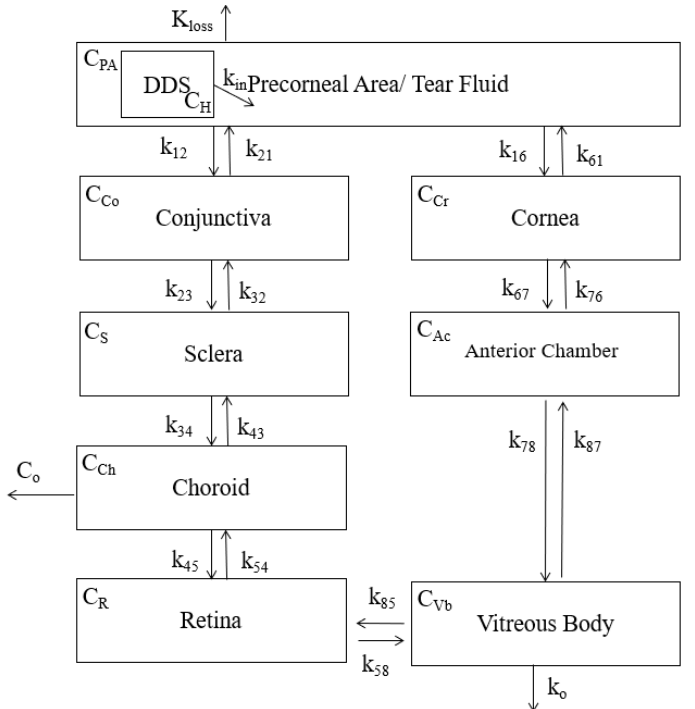
Figure 4. Compartment model that considers the layers of tissues that a drug must transverse in order to enter the vitreous chamber following topical entry. The encapsulated drug flows out of the DDS into the precorneal area where it mixes with the tear fluid. From there, it can pass either through the cornea and the anterior chamber or alternatively, through the conjunctiva, sclera, choroid, and retina before finally reaching the vitreous. Drug loss (K loss ) due to fluid runoff from the eye is also considered. C H , C PA , C Co , C S , C Ch , C R , C Cr , C Ac and C Vb represent the drug concentration in their respective compartments. C o is the fraction of drug lost from the choroid. All values of k represent the rate of drug flow into and out of their respective compartments.